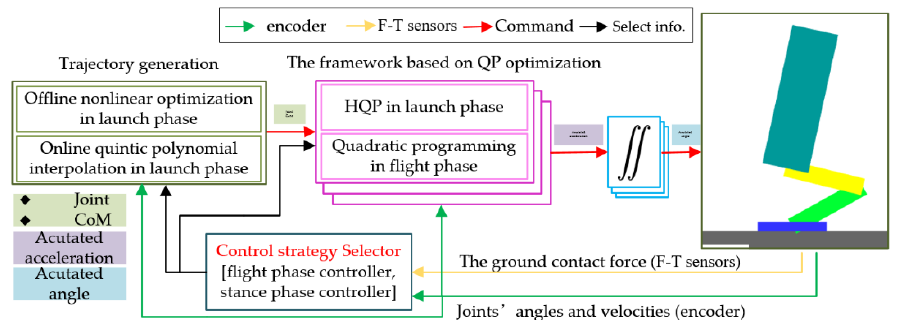
Figure 1. Overview of the online control algorithm.